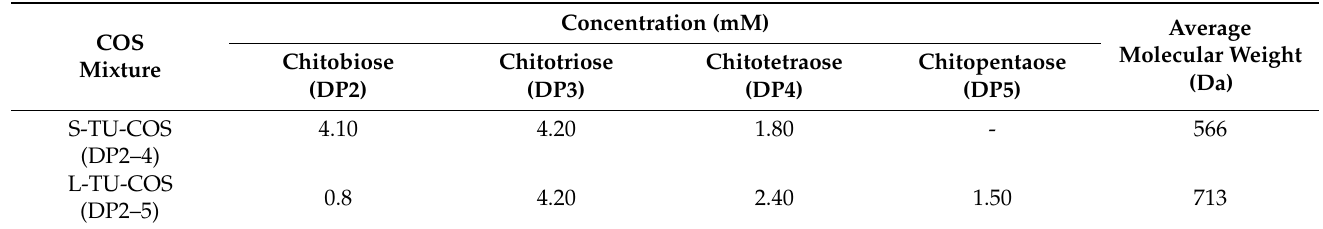
Table 1. The concentration of each DP in S-TU-COS and L-TU-COS and their average molecu- lar weight.